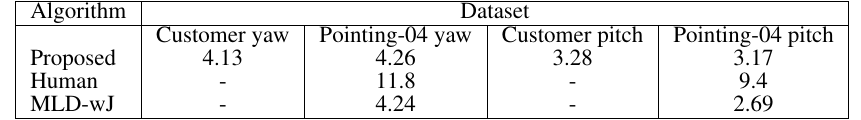
Table 1. MAE for pitch,yaw estimation